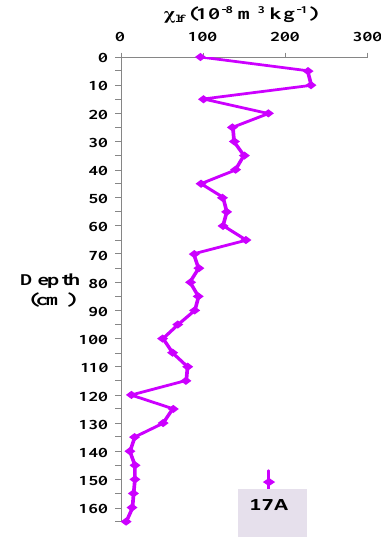
Figure 3. Depth distribution of magnetic susceptibility χ lf in the reference core site (17A)